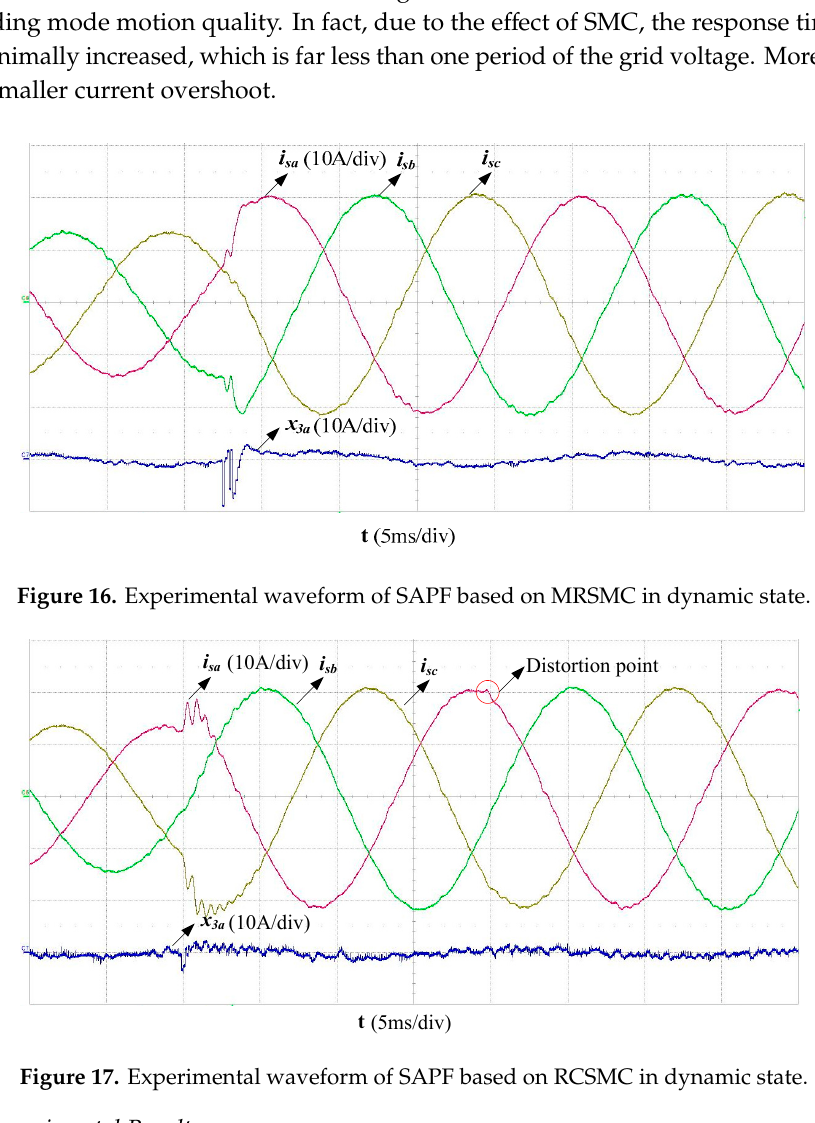
Figure 17. Experimental waveform of SAPF based on RCSMC in dynamic state.